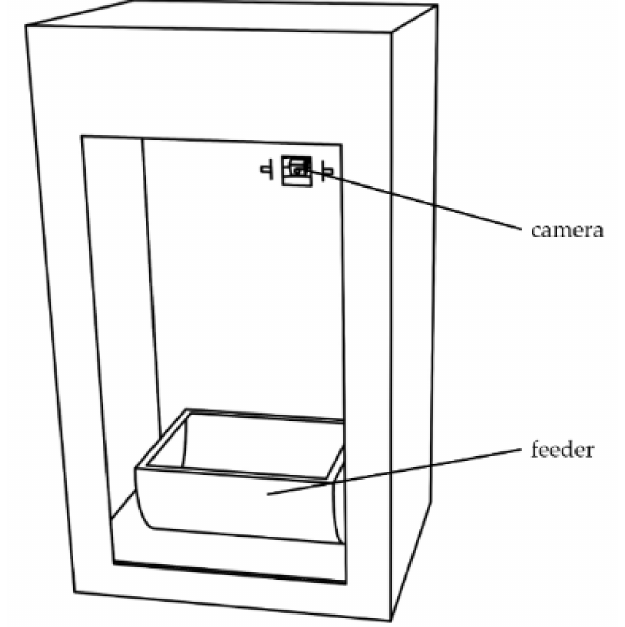
Figure 1. Feeding behavior acquisition and recognition